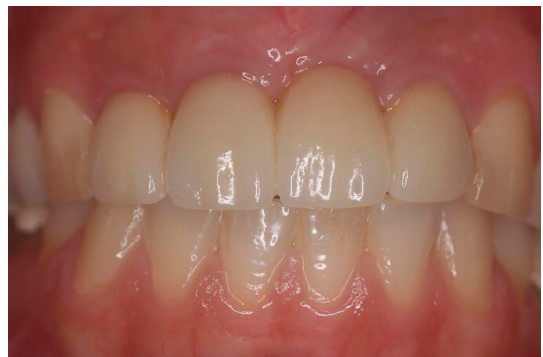
Figure 5. Fixed partial zirconia bridges. The mesial and distal papillae were present six months after implant placement.